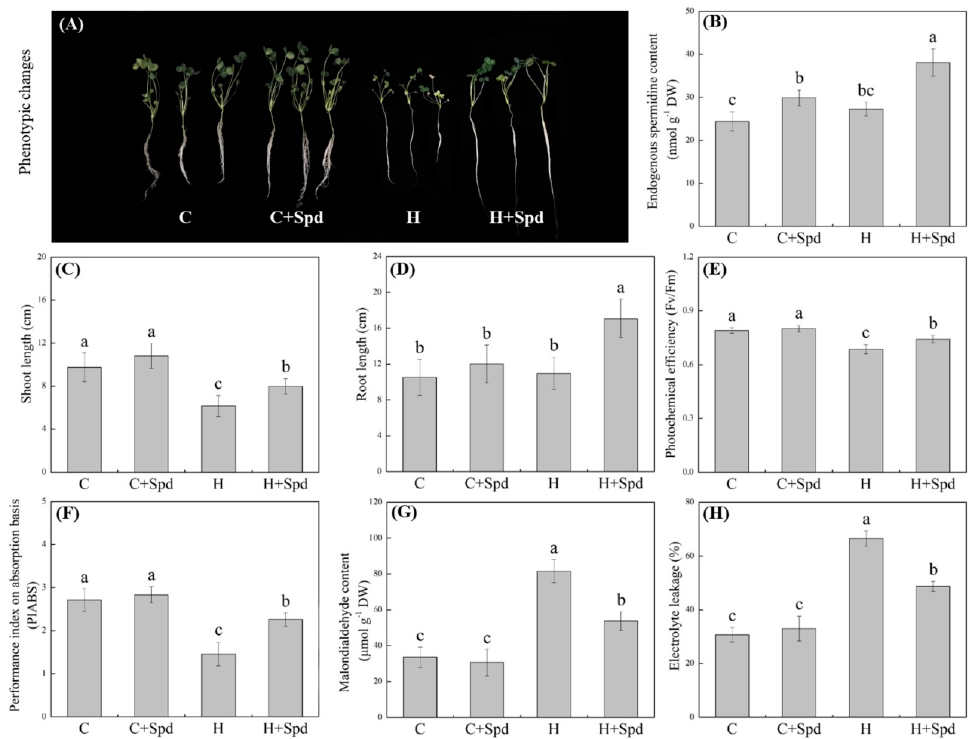
Figure 1. Changes in ( A ) phenotype, ( B ) endogenous spermidine (Spd) content, ( C ) shoot length, ( D ) root length, ( E ) photochemical efficiency, ( F ) performance index on absorption basis, ( G ) malondialdehyde content, and ( H ) electrolyte leakage in leaf of white clover in response to exogenous Spd and heat stress. Vertical bars indicate ±SE of mean ( n = 4) and different letters above column indicate significant differences ( p ≤ 0.05) among treatments.